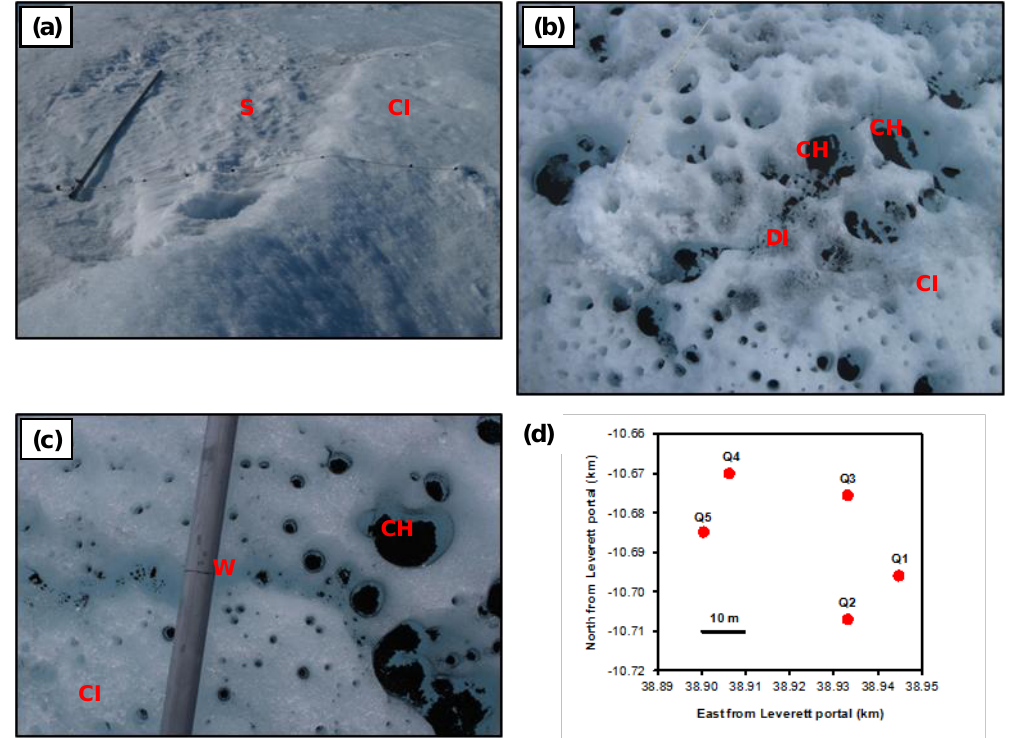
Figure 4. (a) Q2, 1 June 2012, showing the quadrat ropes and pole. Surface cover is 55% snow (S) and 45% clean ice (CI). (b) Lower left corner of Q4, 13 July 2012, with clean ice (CI), dirty ice (DI) and cryoconite holes (CH; Note that CS incubations sampled both the sediment and overlying water from these holes; CW incubations sampled only the water). (c) Q4 on 29 July, with a very small melt water channel linking cryoconite holes under the mark on the pole. (d) Locations of quadrats on 1 June 2012, co-ordinates are relative to the portal from which melt water draining from the field site emerges at the ice